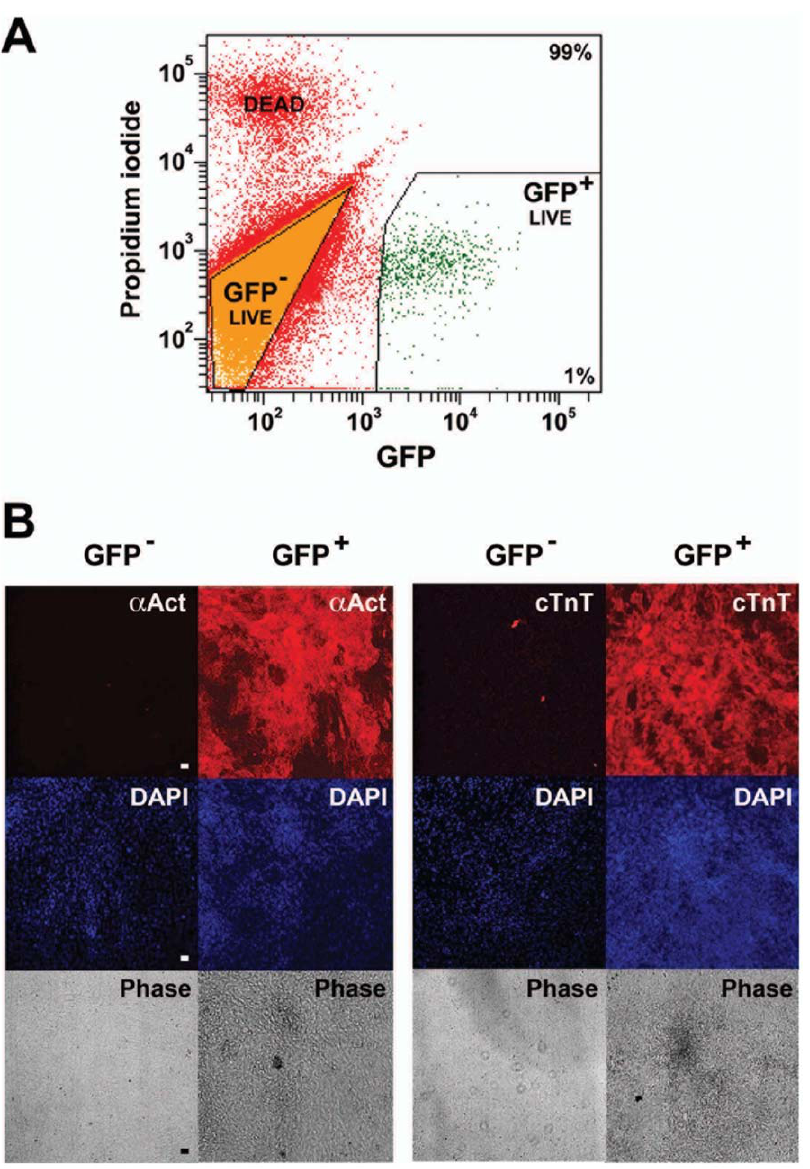
Figure 2. Sorted a MHC-GFP + hESCs form CMs invitro . a MHC-GFP hESCs were cultured under differentiation conditions for 8 days. (A) Day 8 hEBs were suspended as single cells and sorted for GFP expression. Propidium iodide was used to discriminate live versus dead cells. A typical sort is shown. (B) GFP + cells were re-cultured under differentiation conditions for an additional 6 days, then analyzed in situ by indirect immunofluorescence for expression of cTnT and cardiac a -actinin. Cells were counterstained with DAPI to identify nuclei. Typical micrographs are shown. Expression of cTnT and cardiac a -actinin was seen throughout the culture, which demonstrated multiple foci of spontaneous contractile activity ( Supplementary Videos 1 and 2 ). Bar, 400 m m.